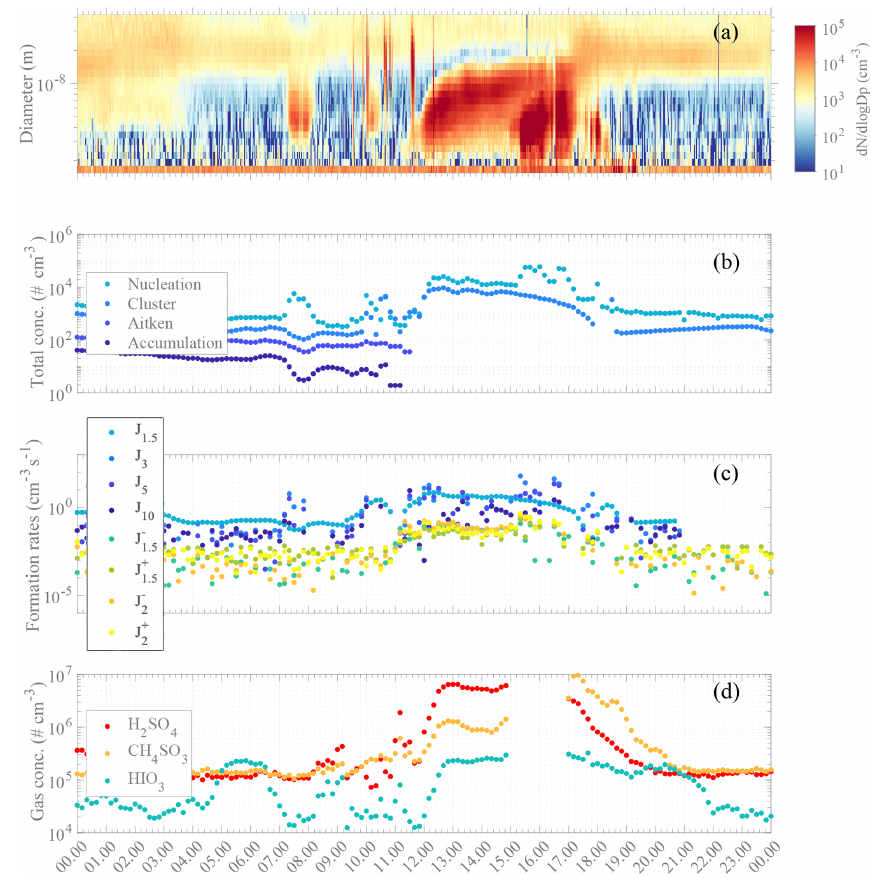
Figure 6. Overview of aerosol formation event on 16 February 2018: (a) number size distribution from NAIS measurements (particle mode). (b) Concentrations of particle modes (cluster: sub-3nm – medium light blue; nucleation: 3–25nm – light blue; Aitken: 25–100nm – medium dark blue; accumulation: 100–1000nm – dark blue). Note that the missing points for Aitken and accumulation modes are due to data filtering from suspected pollution from the DMPS data set. (c) Formation rate estimation for J 1 . 5 (neutral – light blue, negative ( − ) – blue green, positive ( + ) – green), J 2 (negative ( − ) – orange, positive ( + ) – yellow), J 3 (medium light blue), J 5 (medium dark blue), and J 10 (dark blue). Note that the formation rate calculation depends on the condensation and coagulation sinks calculated from the DMPS data. (d) High-resolution time series of H 2 SO 4 (red), CH 4 SO 3 (orange), and HIO 3 (green). Note that the data gap is due to the ion mode of APi measurement. All data are averaged and estimated with a 10min time resolution, with standard local time (UTC − 3) as the clock reference.